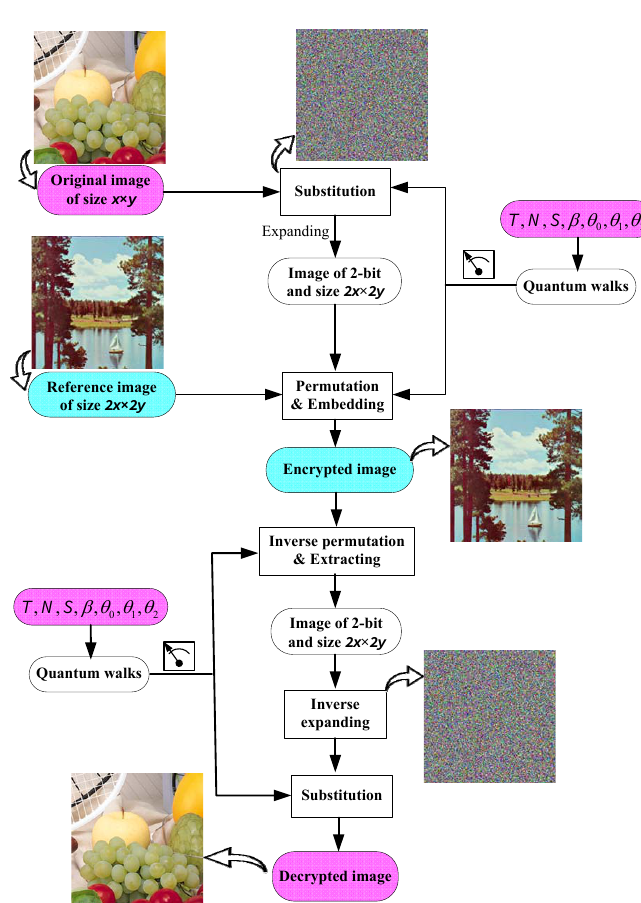
Figure 2. The outline of the presented visually encryption